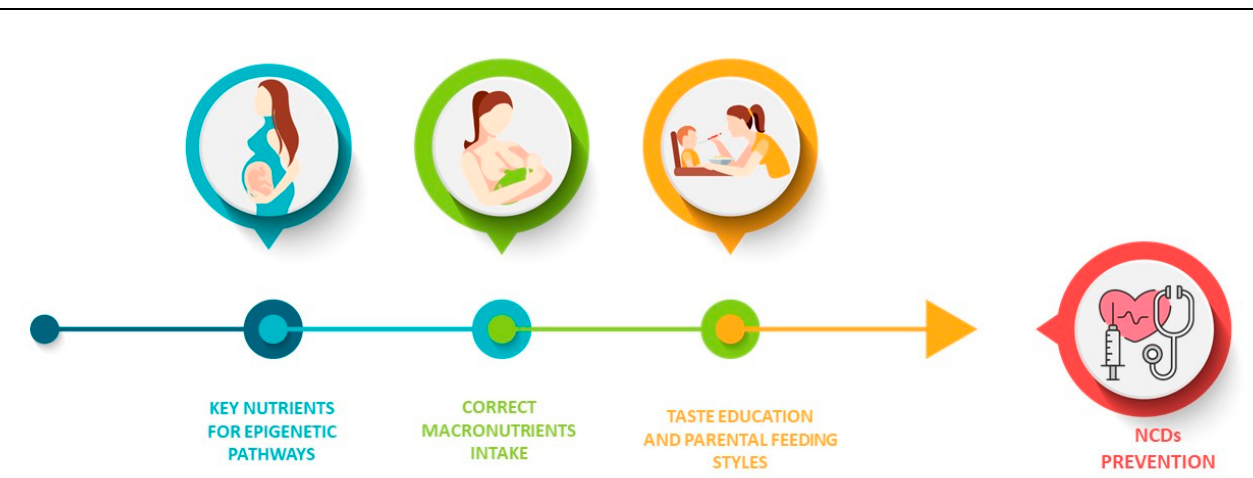
Figure 2. The crucial role of nutrition in the first 1000